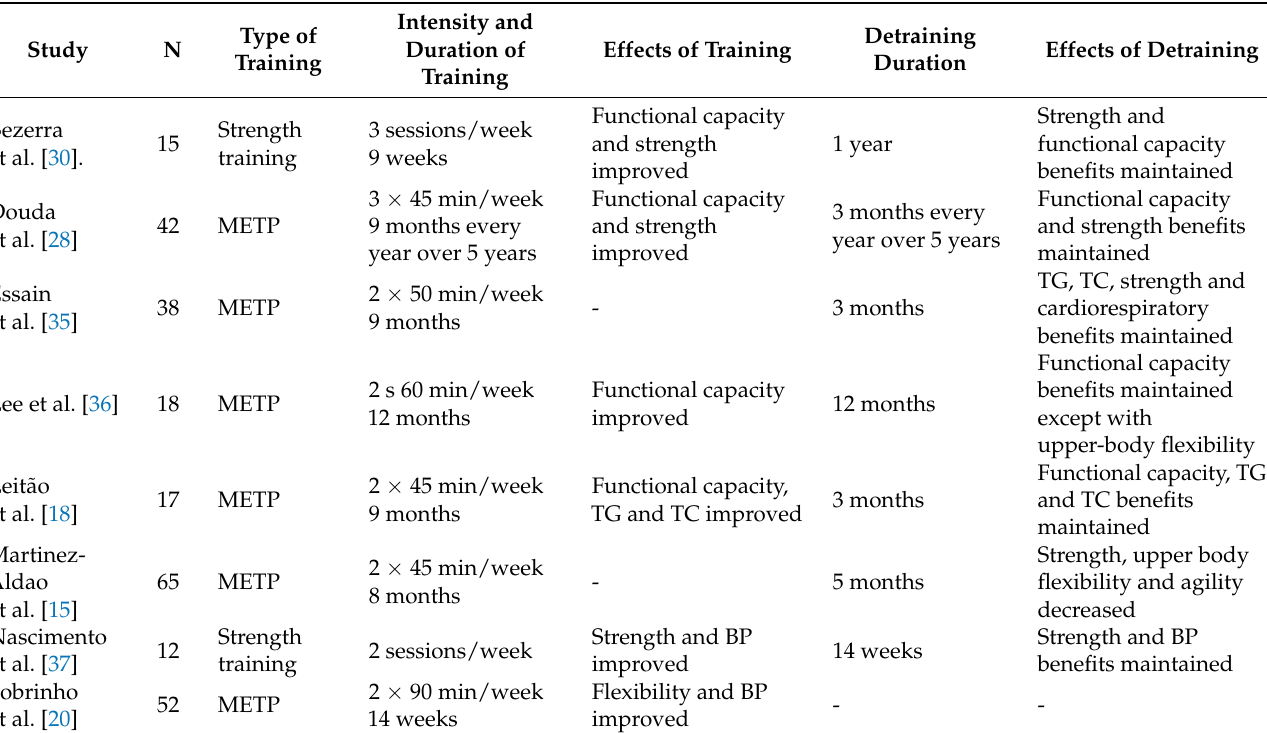
Table 3. METP and detraining effects in older adults in other